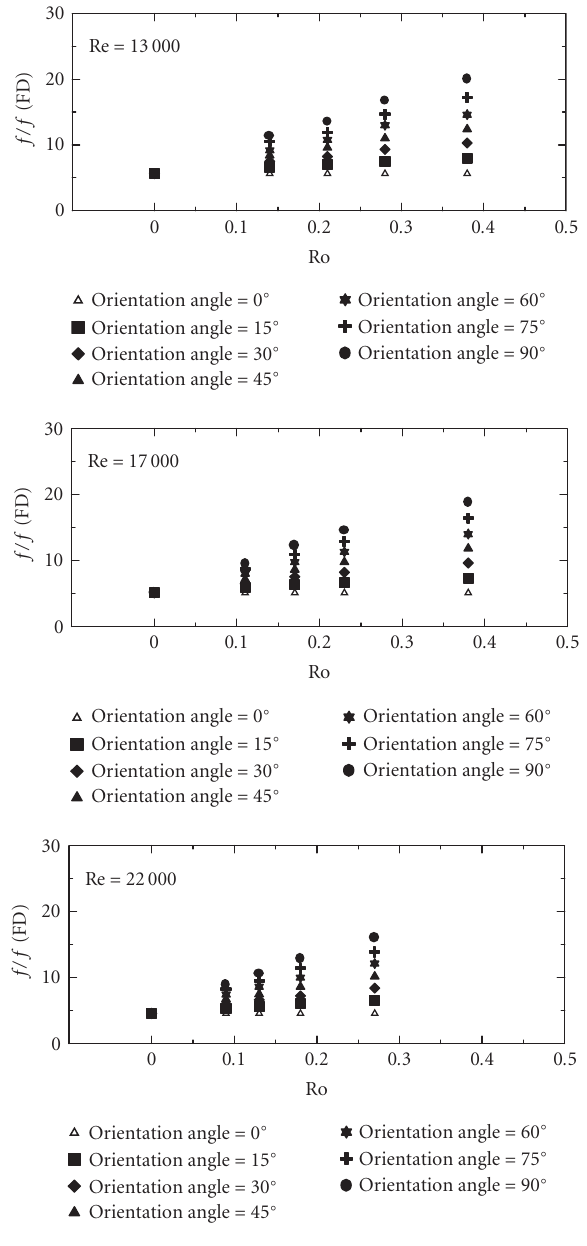
Figure 4: E ff ect of the orientation angle for 90 ◦ ribbed radial out- ward flow channel for a rib pitch-to-height ratio of